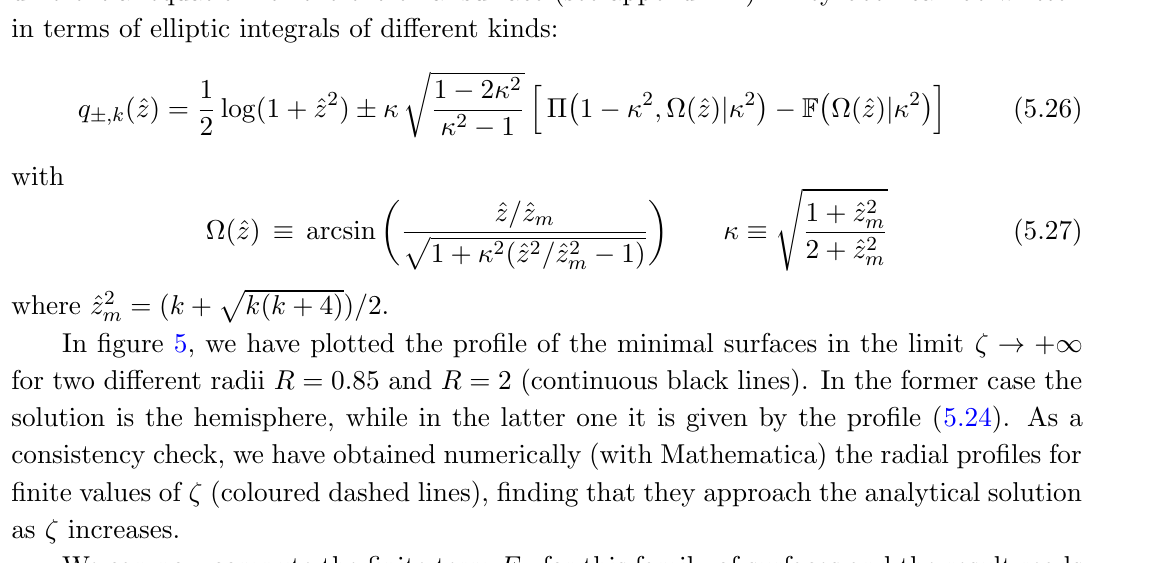
R 2 (cid:26) 2 , otherwise they are given by (5.24). (cid:0) p